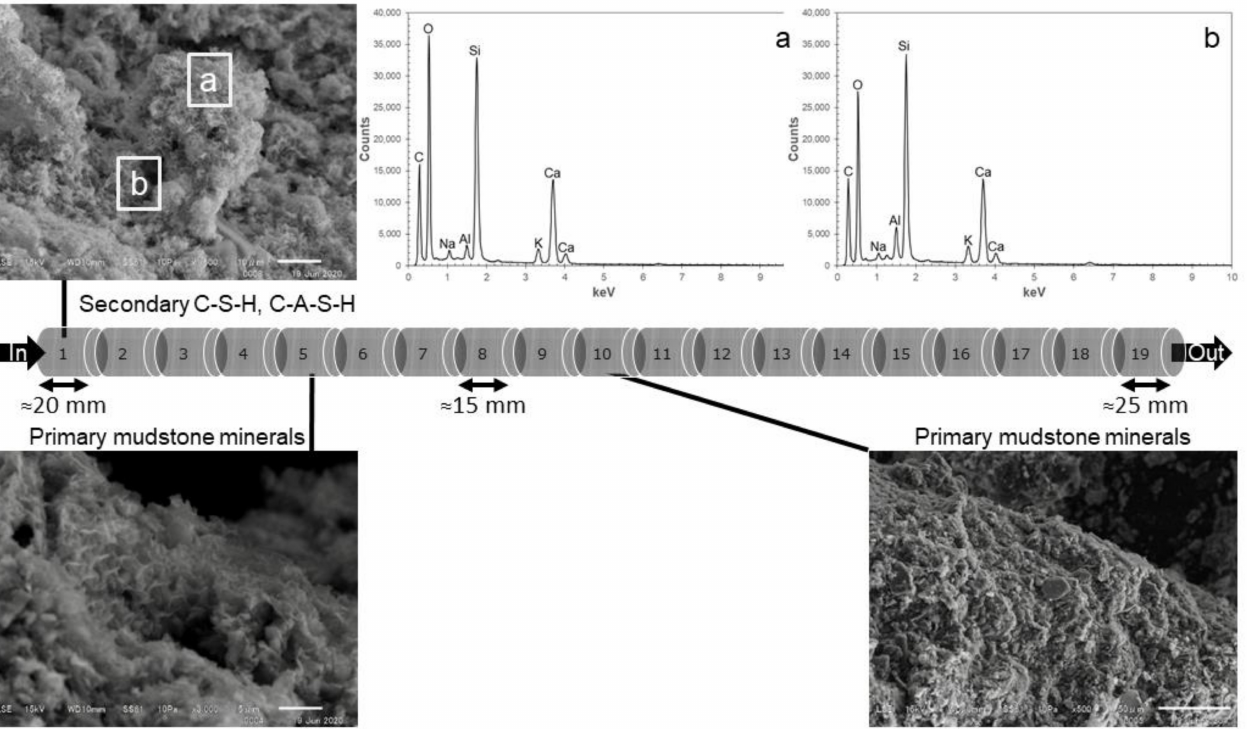
Figure 4. Summary of mineralogy, column experiment with the ‘young’ OPC leachate. Arrows indicate direction of flow; numerals refer to Section numbers; each Section (apart from Sections 1 and 19) ~15 mm long. All SEM photos are secondary electron (SE) images. White squares ( a , b ) in the SEM image from Section 1 indicate areas used for SEM-EDS analysis of C(A)-S-H